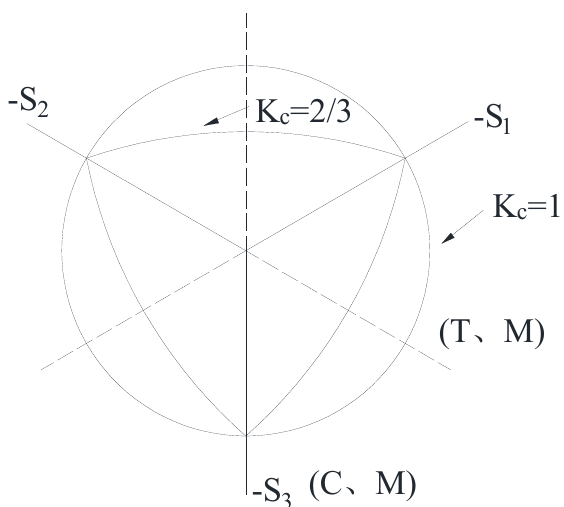
Figure 10. Yield surface in plane stress state.